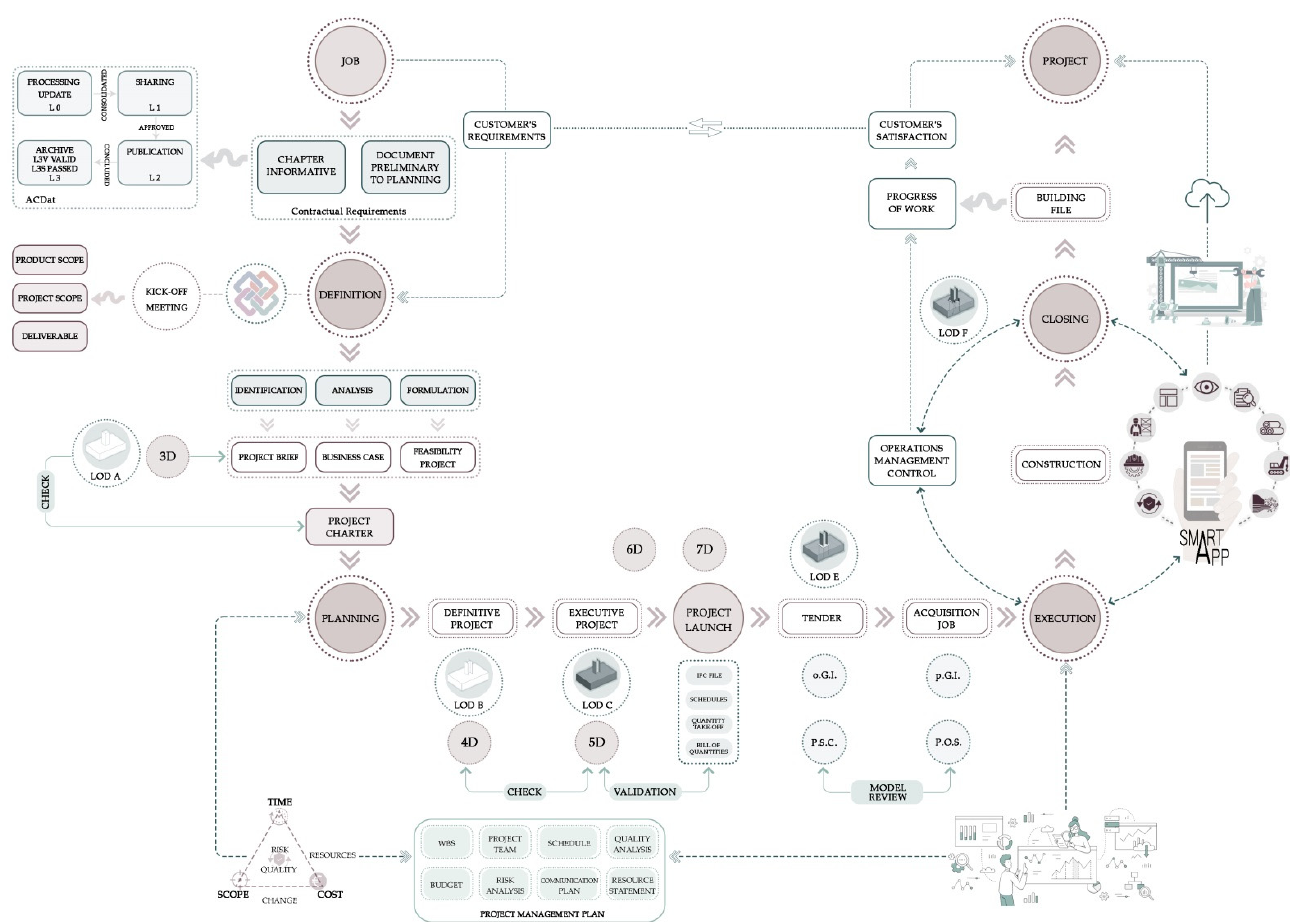
Figure 1. Framework for the integrated management of job – Model Smart Management.